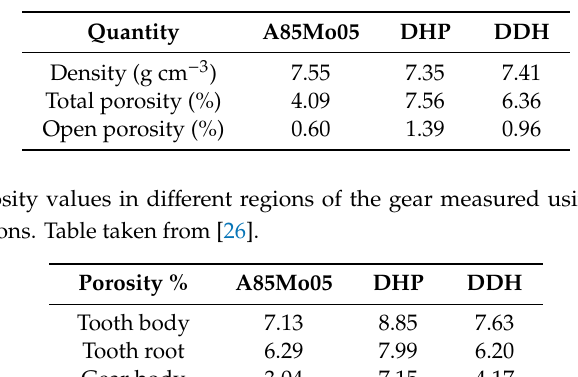
Table 3. Mean density, total porosity and open porosity following ASTM B311. Table taken from [26].